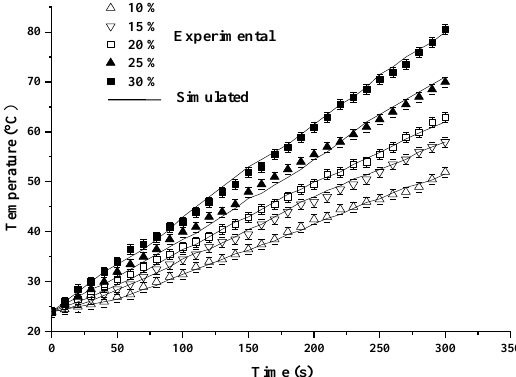
Figure 4. Experimental and simulated temperature-time histories of pecan kernels with a moisture content from 10% to 30% wb when subjected to RF heating for 5 min with an electrode gap of 150 mm.